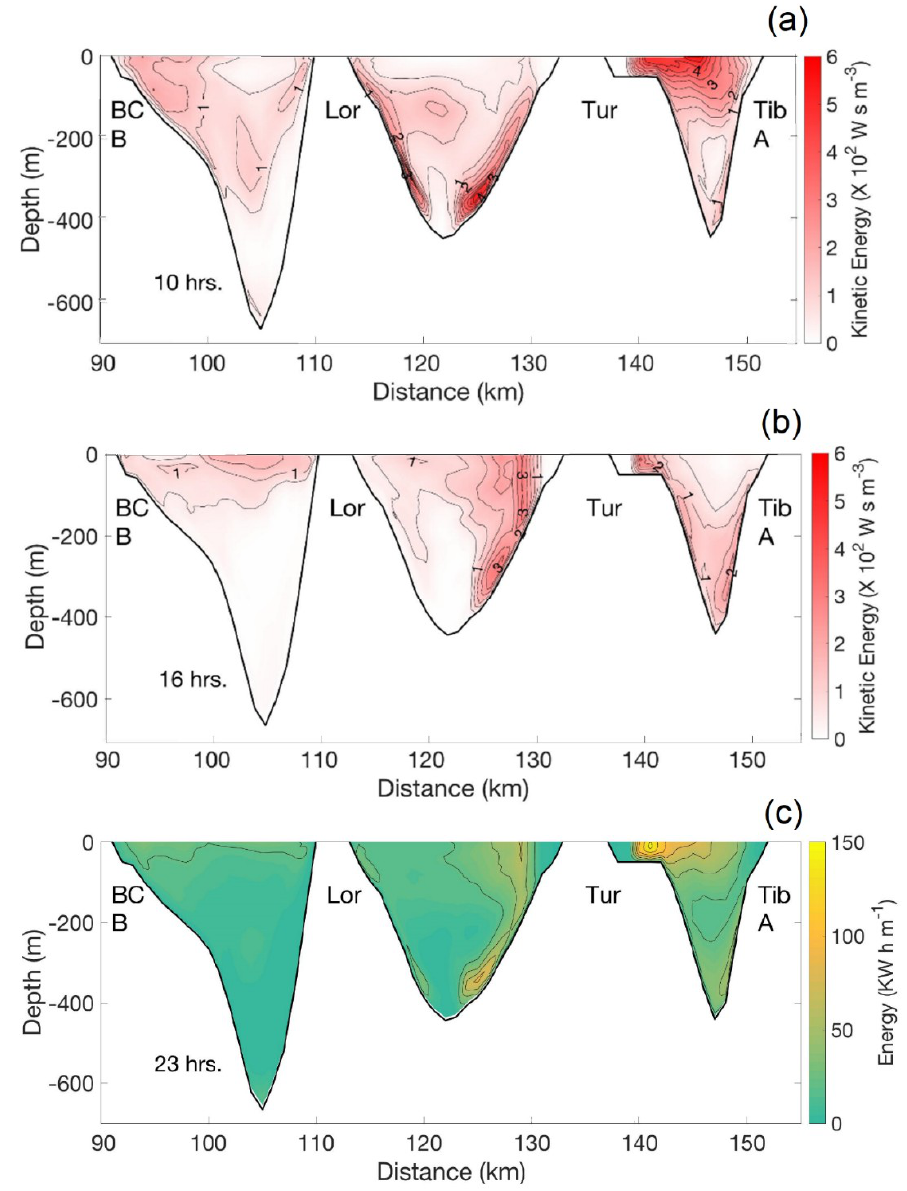
Figure 7. Same as Figure 5 but for kinetic energy (KE) for (a) inflow, (b) outflow. Panel (c) is the average tidal power density for a total tidal cycle.